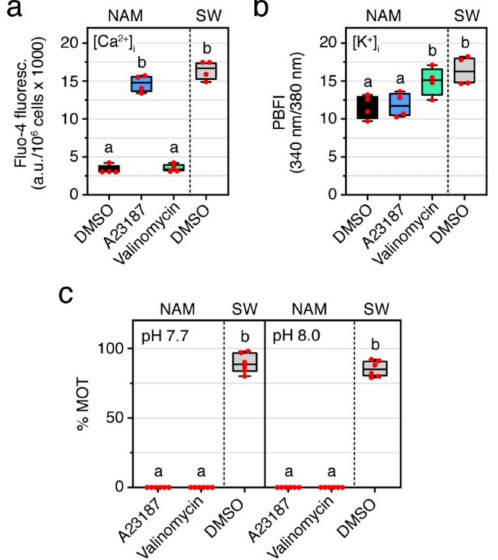
Figure 3. High levels of intracellular Ca 2+ and basic pH are not sufficient for the activation of motility of seabream spermatozoa. ( a , b ) Intracellular Ca 2+ ( a ) and K + ( b ) levels in immotile sperm treated with 25 mM of the Ca 2+ ionophore A23187 or the K + ionophore valinomycin for up to 30 min, and in SW-activated spermatozoa. ( c ) Percentage of motility (% MOT) of the sperm treated as above under neutral and basic pH. In all panels, the data points are presented as box and whisker plots/scatter dots with horizontal line (inside box) indicating median and outliers. One ejaculate from each male was measured from n = 4–6 males. Statistical differences were measured by one-way ANOVA. Boxes with different superscript are statistically significant ( p <